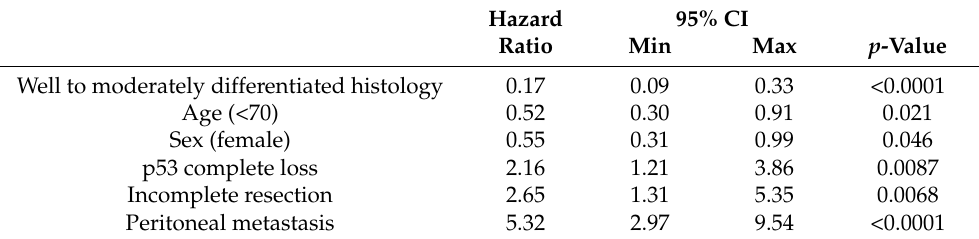
Table 4. Multivariable Cox hazards analysis of colorectal cancer patients. Hazard 95% CI Ratio Min Max p -Value Well to moderately differentiated histology 0.17 0.09 0.33 <0.0001 Age (<70) 0.52 0.30 0.91 0.021 Sex (female) 0.55 0.31 0.99 0.046 p53 complete loss 2.16 Incomplete resection 2.65 Peritoneal metastasis